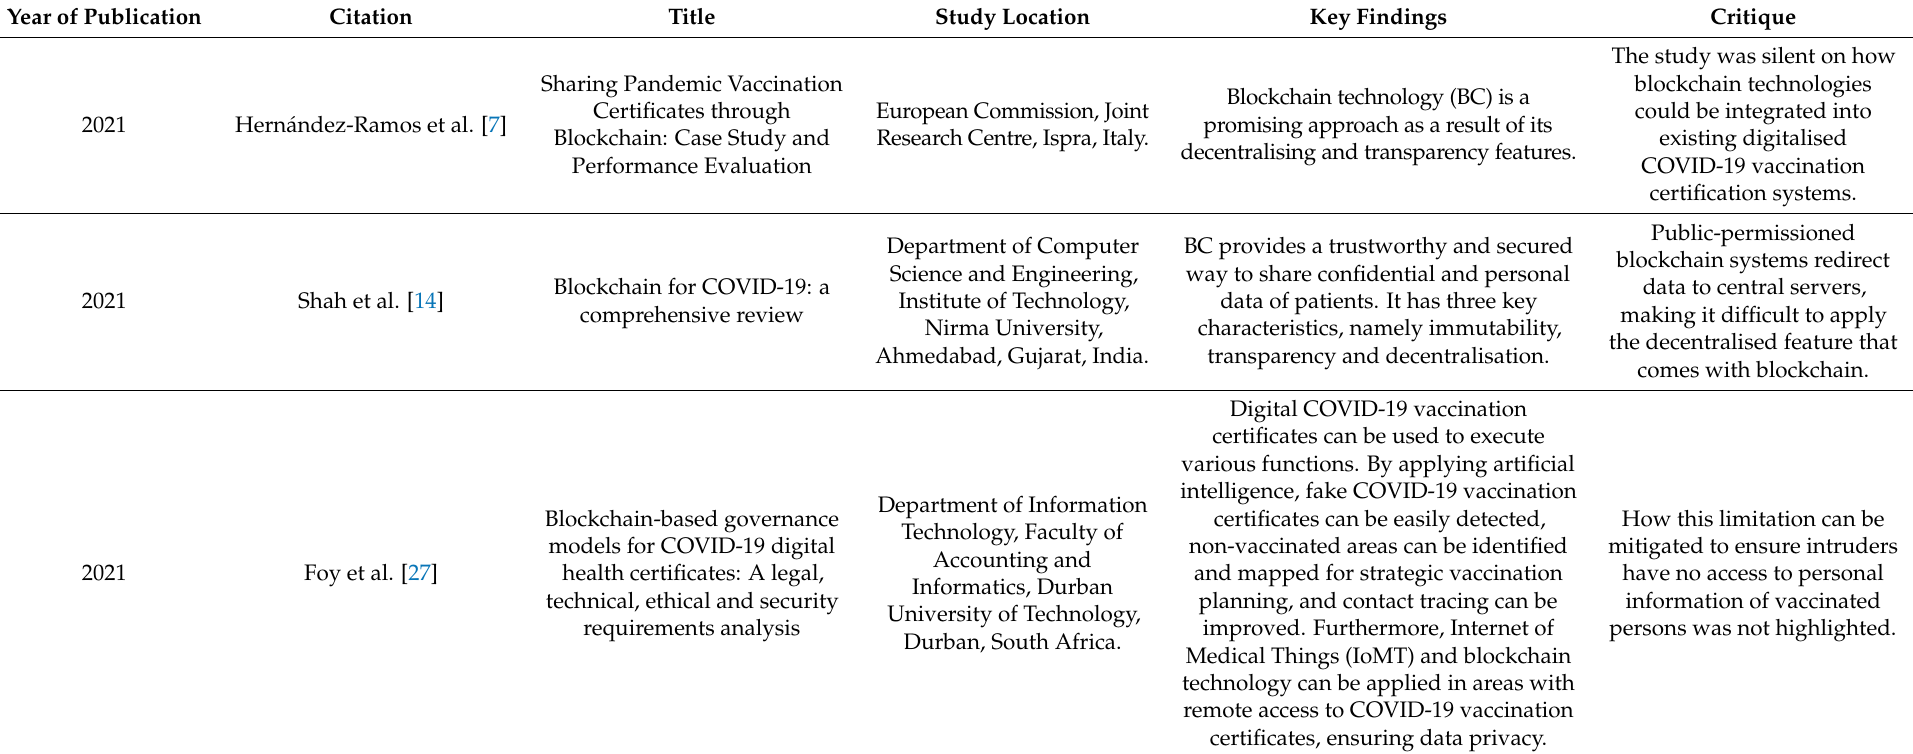
Table 9. Addressing issues of privacy concerns for digital COVID-19 vaccine